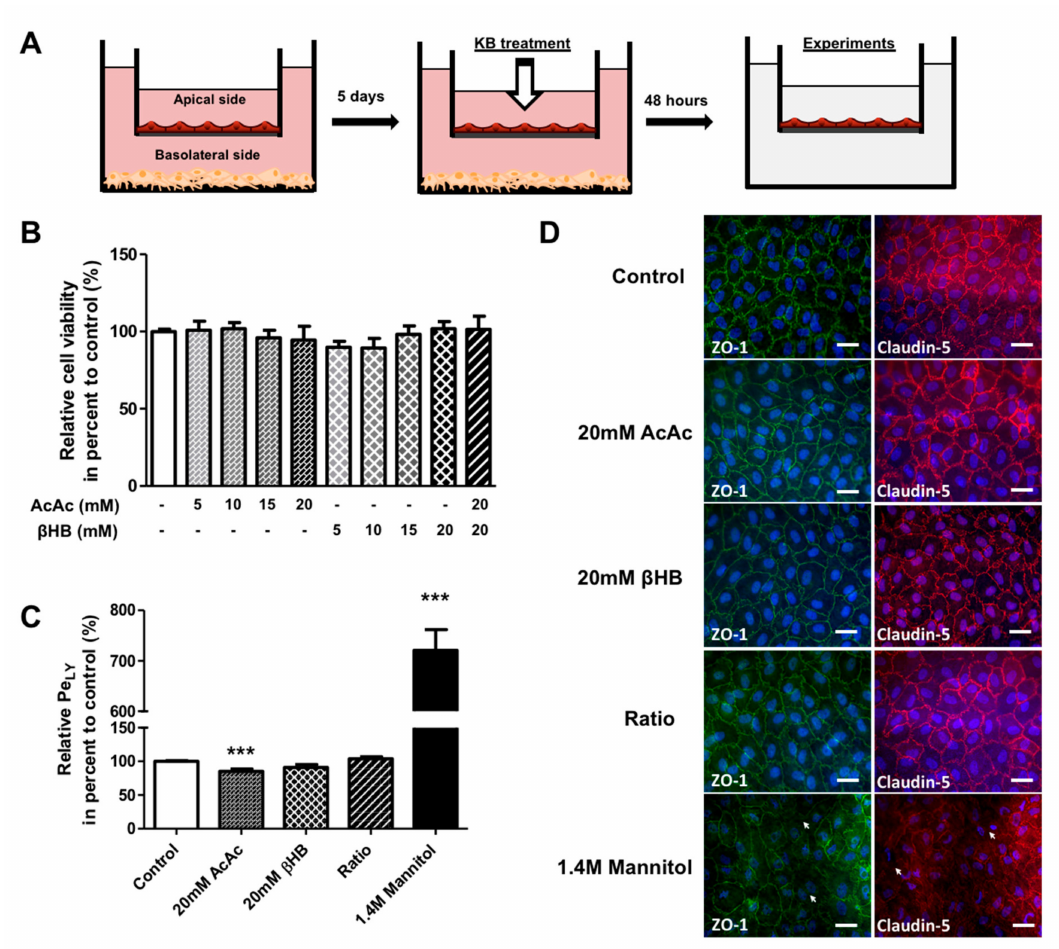
Figure 1. The e ff ect of KBs on BLEC permeability. ( A ) Schematic representation of the human in vitro BBB model used for the KB study. This model is composed of an apical compartment in the filter containing endothelial cells and a basolateral compartment in the well with brain pericytes. After 5 days of co-culture, BLECs were incubated with various concentrations of KBs, AcAc, or β HB alone (5–20 mM) or in in combination (20 mM AcAc / 20 mM β HB) for 48 h. Following KB treatment, the BLECs on the insert were transferred to a new plate for experiments. ( B ) The e ff ects of KBs on cell viability were analyzed by MTT assay. ( C ) BLEC monolayer integrity was determined by measuring the endothelial lucifer yellow permeability (Pe LY ). Each bar represents the mean ± SEM relative to the control conditions (Pe LY = 0.92 ± 0.03 × 10 − 3 cm · min − 1 ). The results are representative of three independent experiments performed in triplicate (*** p < 0.001). ( D ) Associated tight junction protein ZO-1 (green) and tight junction protein claudin-5 (red) staining were stained using immunofluorescence. Interruptions in the staining are indicated by white arrows. Nuclei were stained with Hoechst reagent and appear in blue. Scale bar: 50 µ